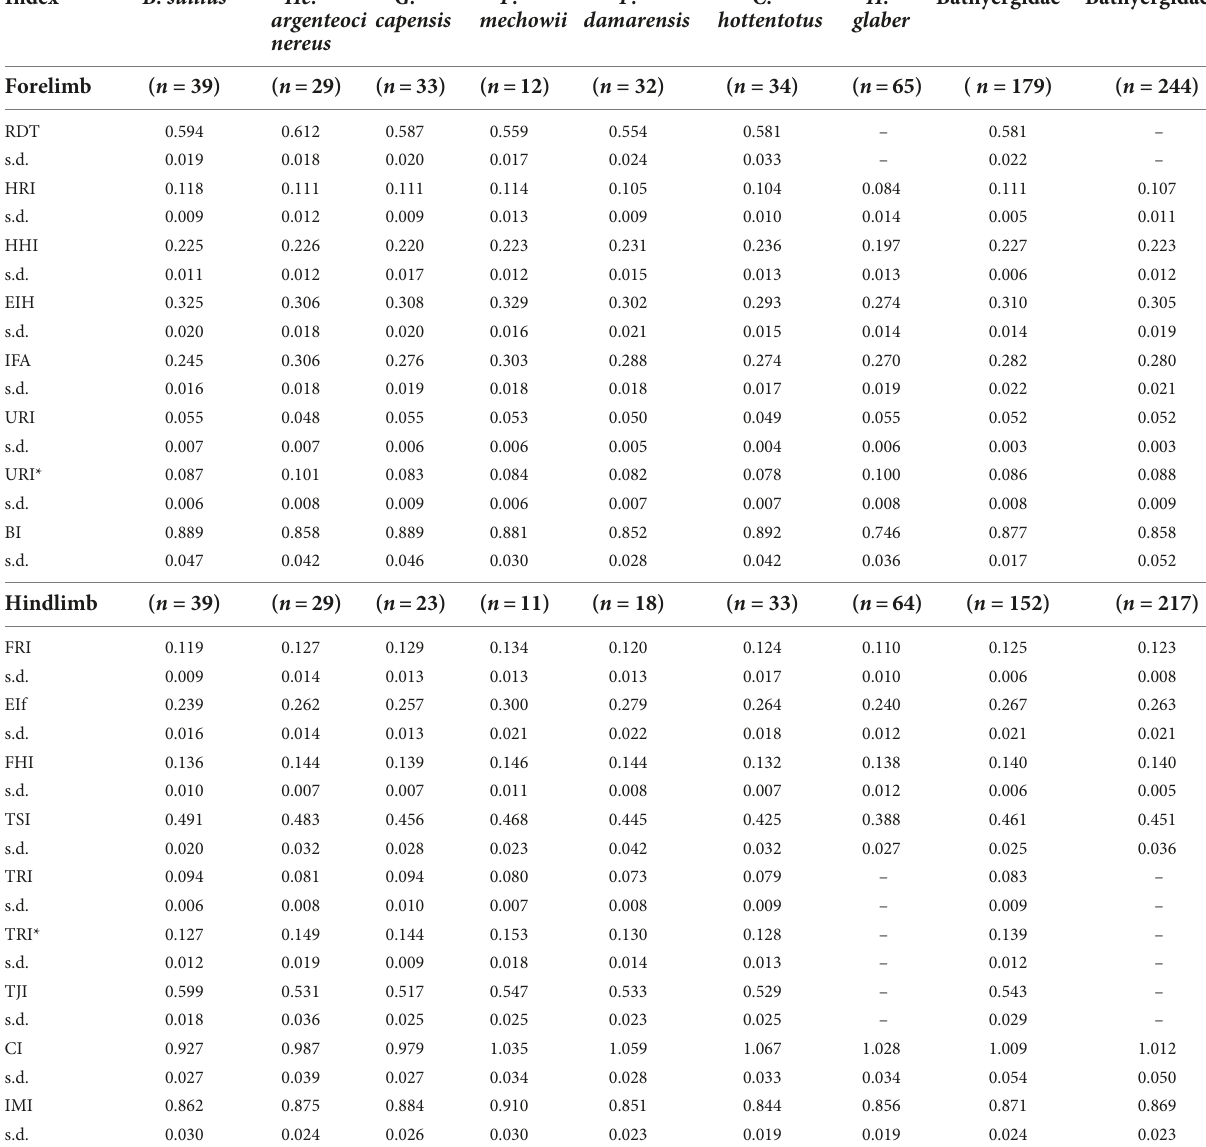
TABLE 3 Descriptive statistics (mean and s.d.) of forelimb and hindlimb morpho-functional